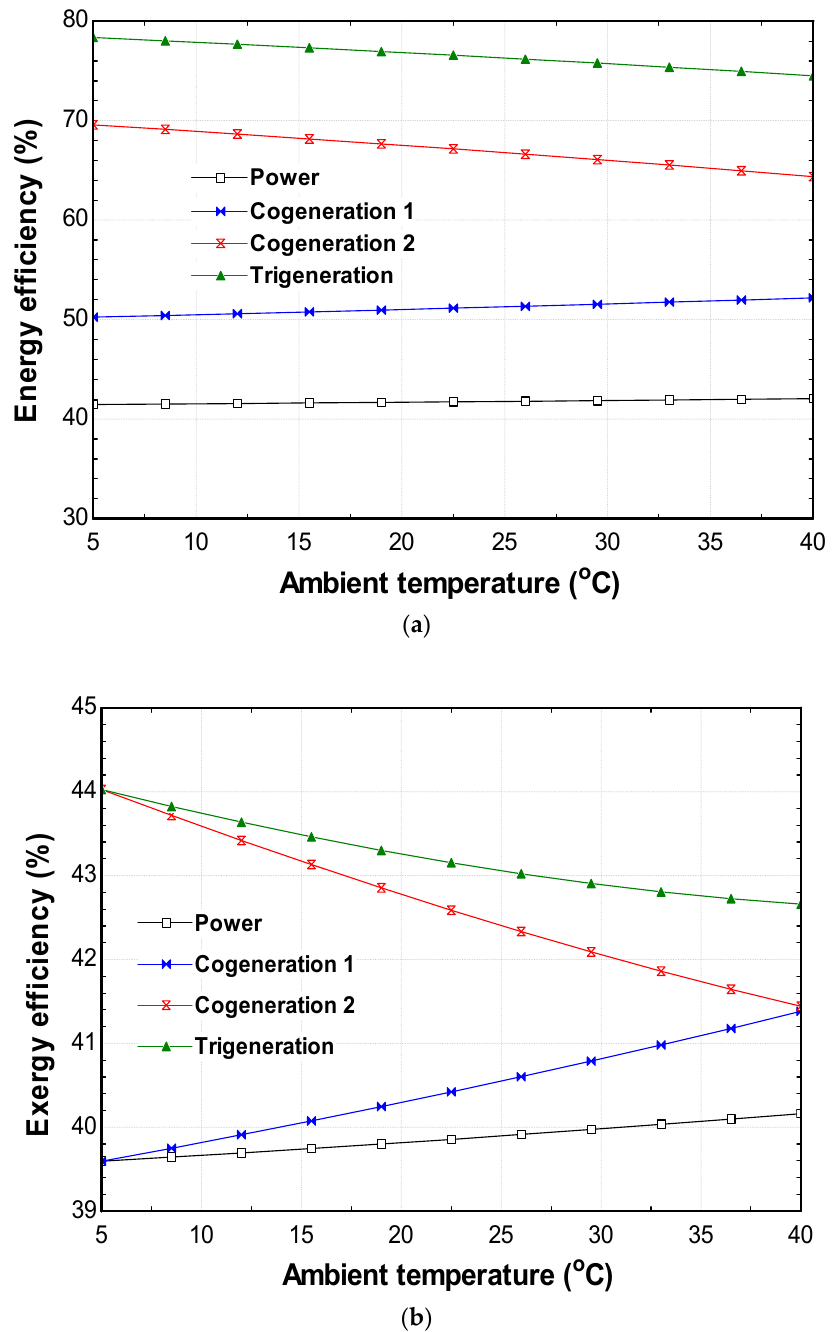
Figure 12. Effect of the ambient temperature on the ( a ) energy and ( b ) exergy performance of the systems